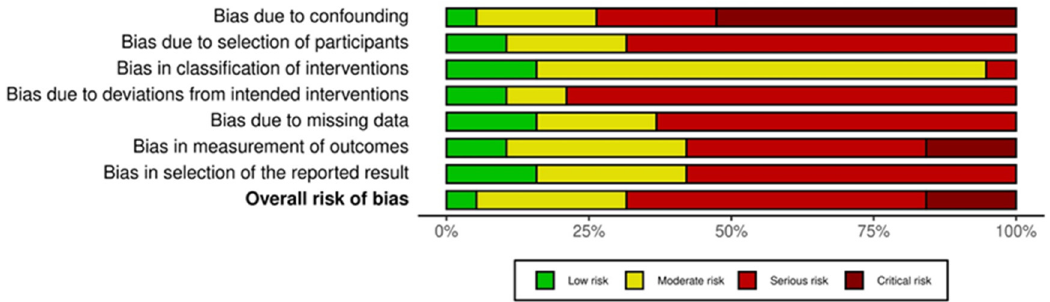
Figure 6. Risk of Bias in Non-Randomized Studies—of Interventions (ROBINS-I) traffic-light plot [16–34].